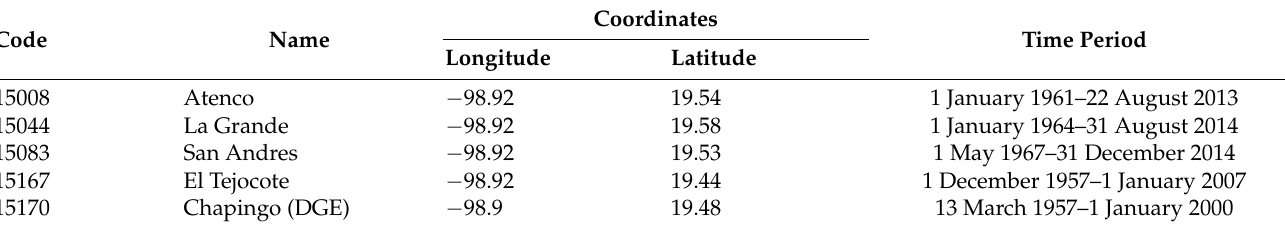
Table 1. Summary of precipitation and evaporation information for each station.